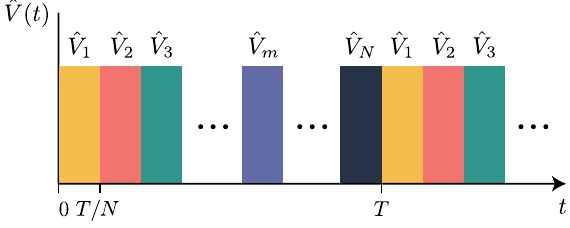
FIG. 2. Schematic representation of the general N -step driving sequence γ introduced in Eqs. (27) and (28), where N ˆ H ˆ V ð t Þ 0 þ